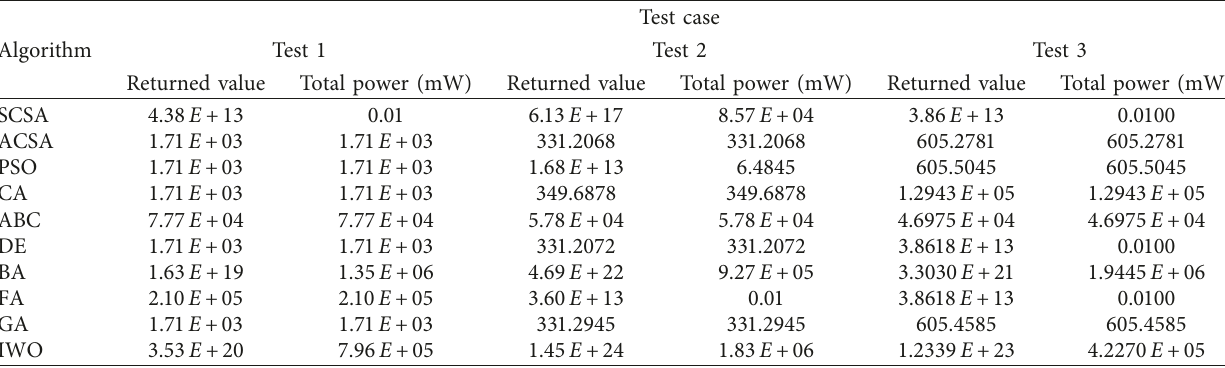
Table 15: Returned values and total power of ACSA and other standard optimization algorithms in Scenario 1 in three more test cases. Algorithm